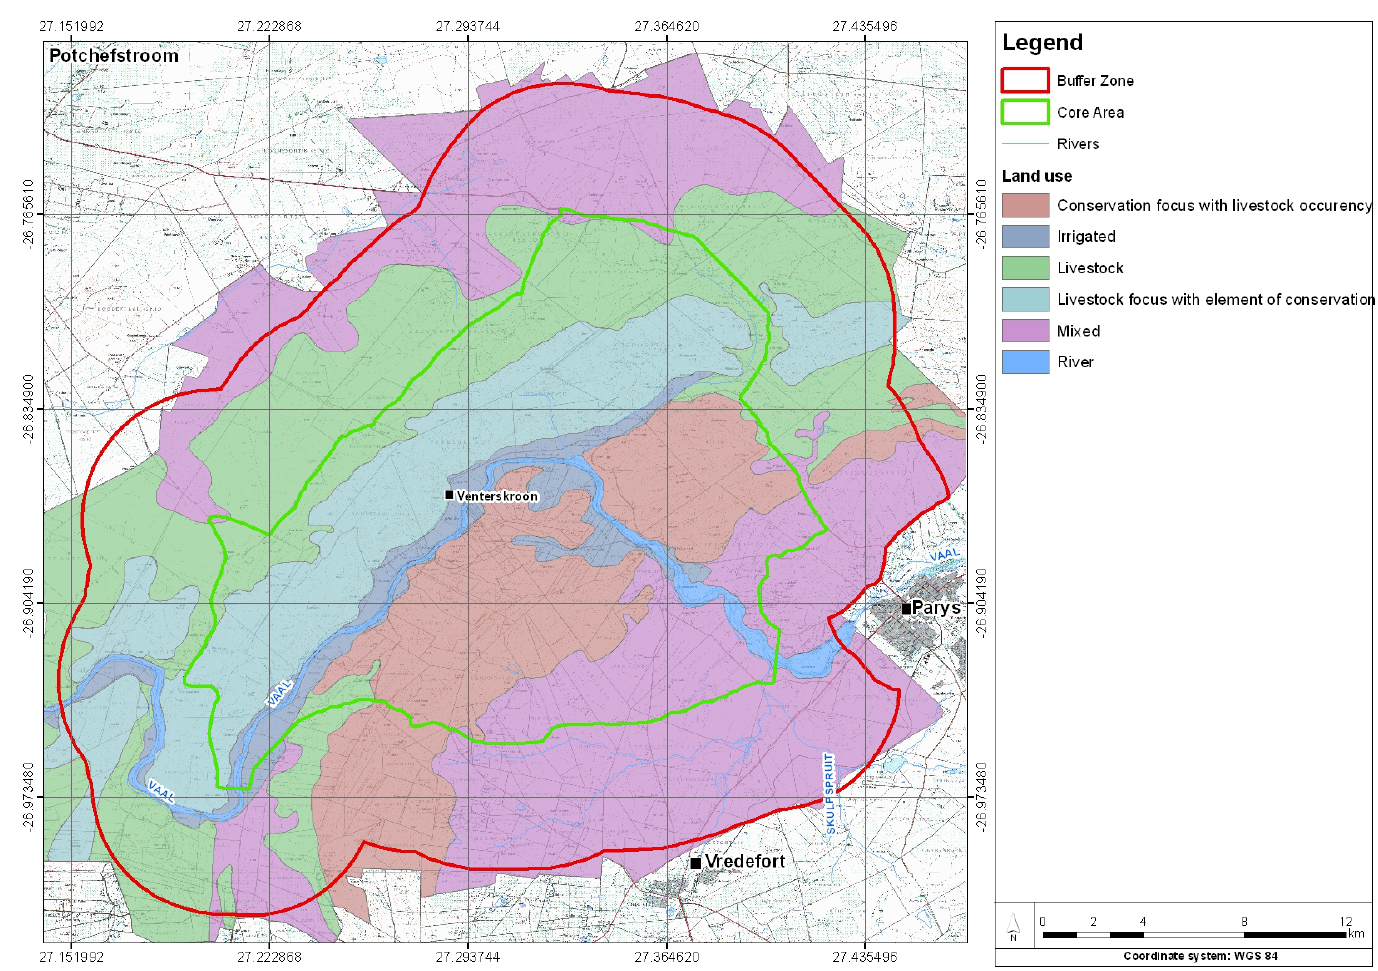
Figure 4. Land-use zones within the